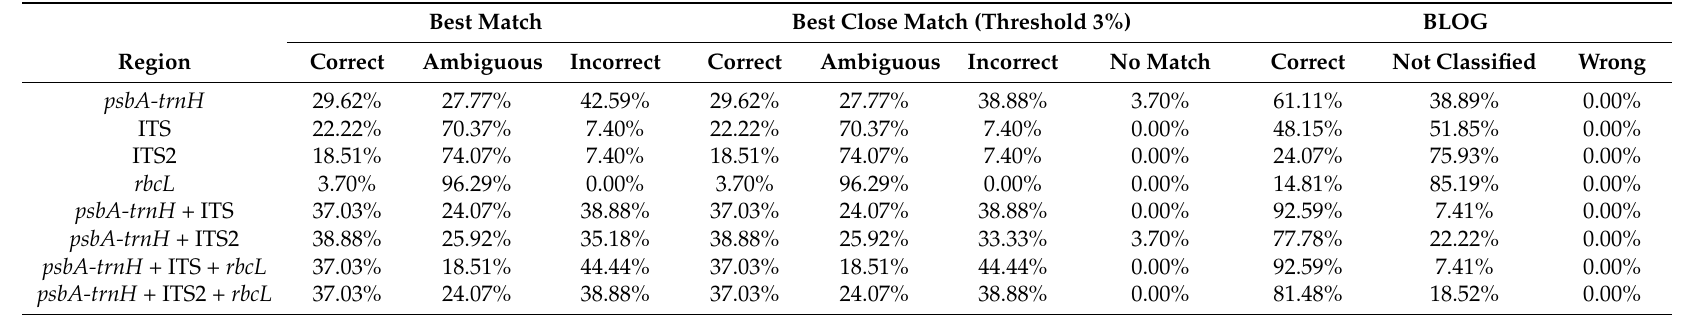
Table 1. Identification efficiency of the four loci on the basis of the BM, BCM, and BLOG analytical